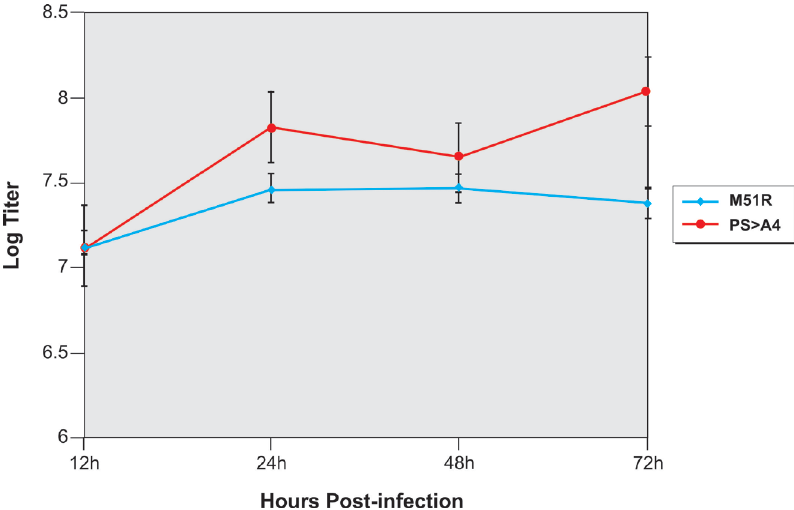
Figure 6. Growth curves in Culicoides sonorensis cells. Culicoides cells were infected with M51R (blue) and PS > A4 (red) at an MOI of 3.0, and virus released into the supernatants at the times indicated was harvested and quantified by standard plaque assay on Vero cells performed in